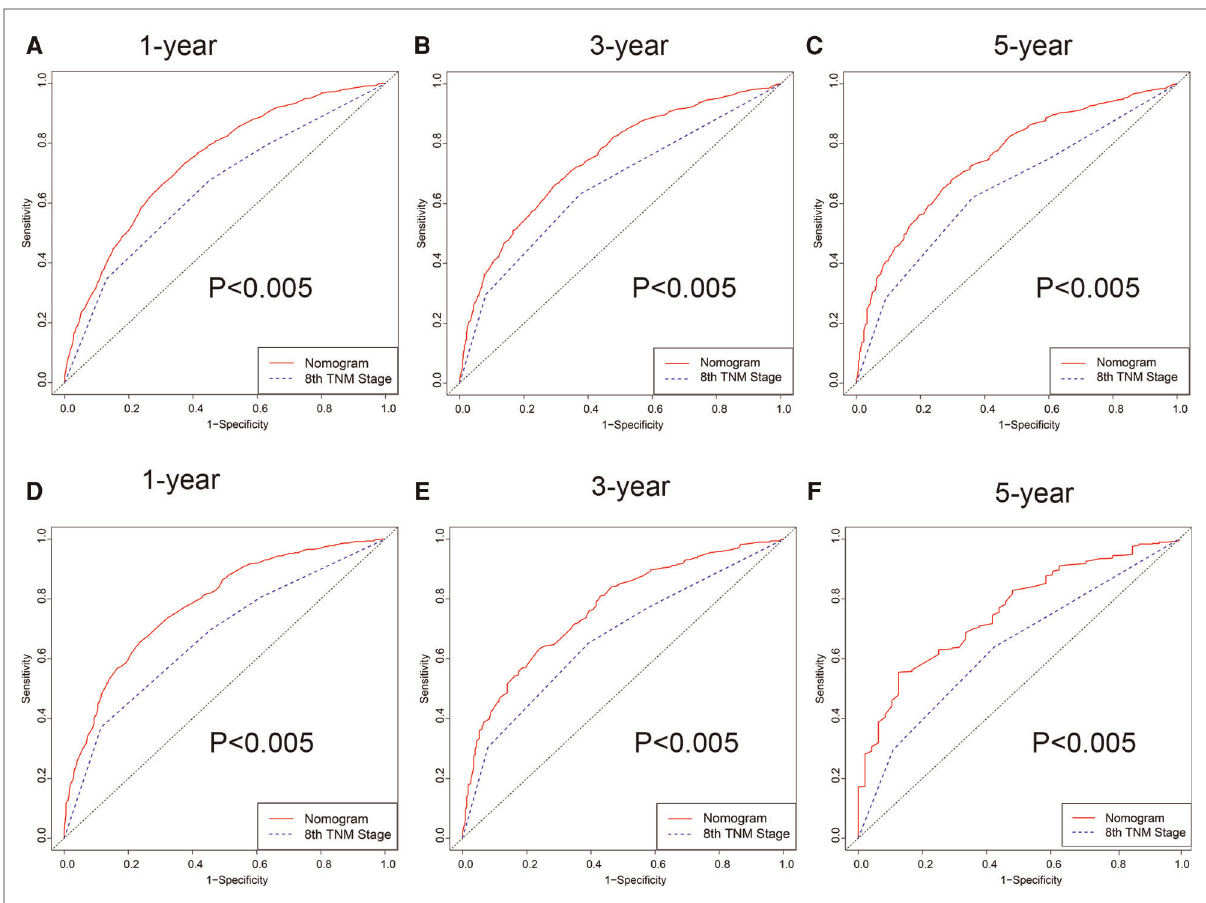
FIGURE 6 ROC curve of the nomogram and 8th TNM stage. ( A – C ) 1-, 3- and 5-year in the 2004 – 2009 cohort. ( D – F ) 1-, 3- and 5-year in the 2010 – 2015